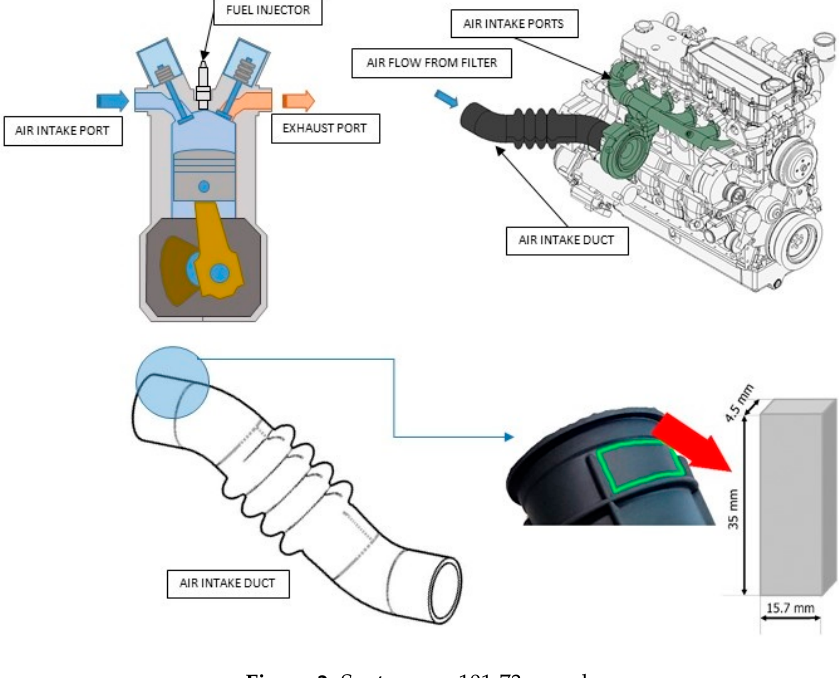
Figure 2. Santoprene 101-73 sample.